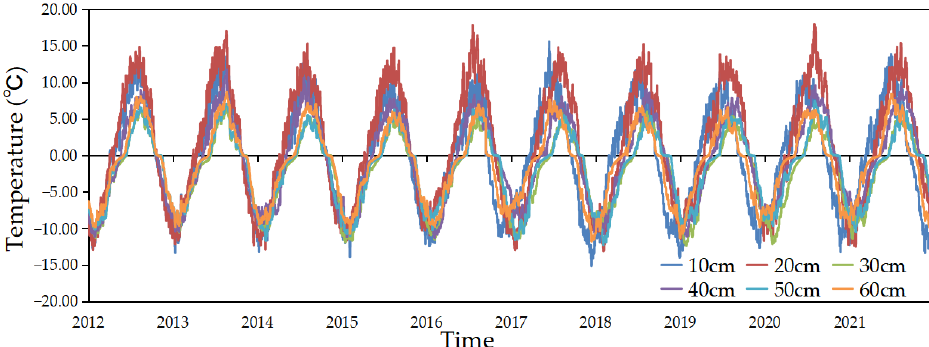
Figure 11. Temporal changes in the mean subsurface temperatures at depths of 10, 20, 30, 40, 50 and 60 cm for the period from 2012 to 2021, obtained by the TLZ model.